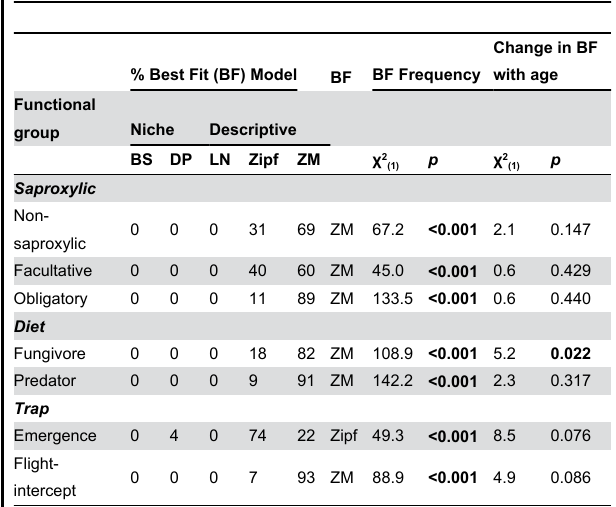
Table 2. Summary of model fits for common functional groups, showing: the percentage of best fit models across the forty-five age classes for each type of model; best fit model; the χ 2 test of whether the frequency of the model that fit best most often differed from expected; and the test of whether the best model changed with age.